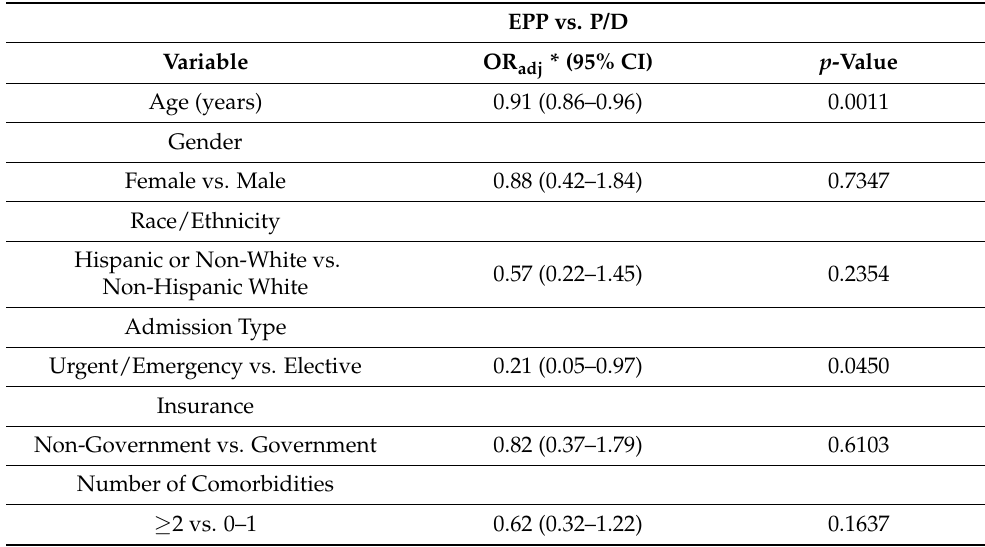
Table 2. Independent Factors Associated with Receipt of EPP vs. P/D ( n =